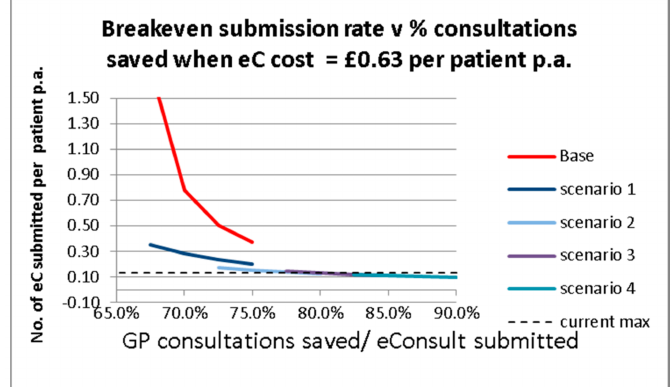
Figure 11. eConsult submission rates required for breakeven at a cost of £1 per